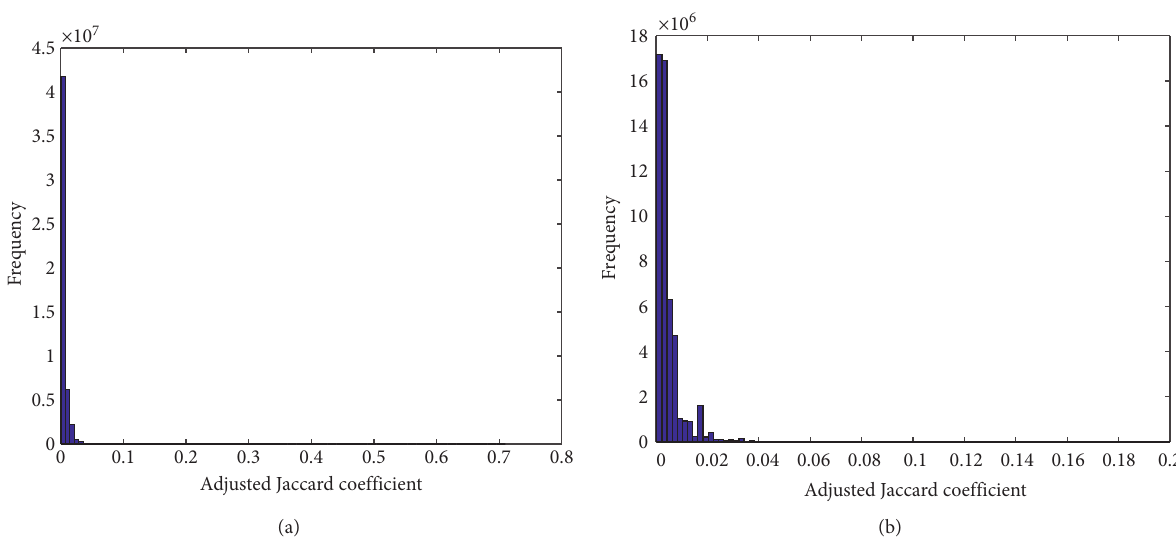
Figure 3: Distribution of ρ a